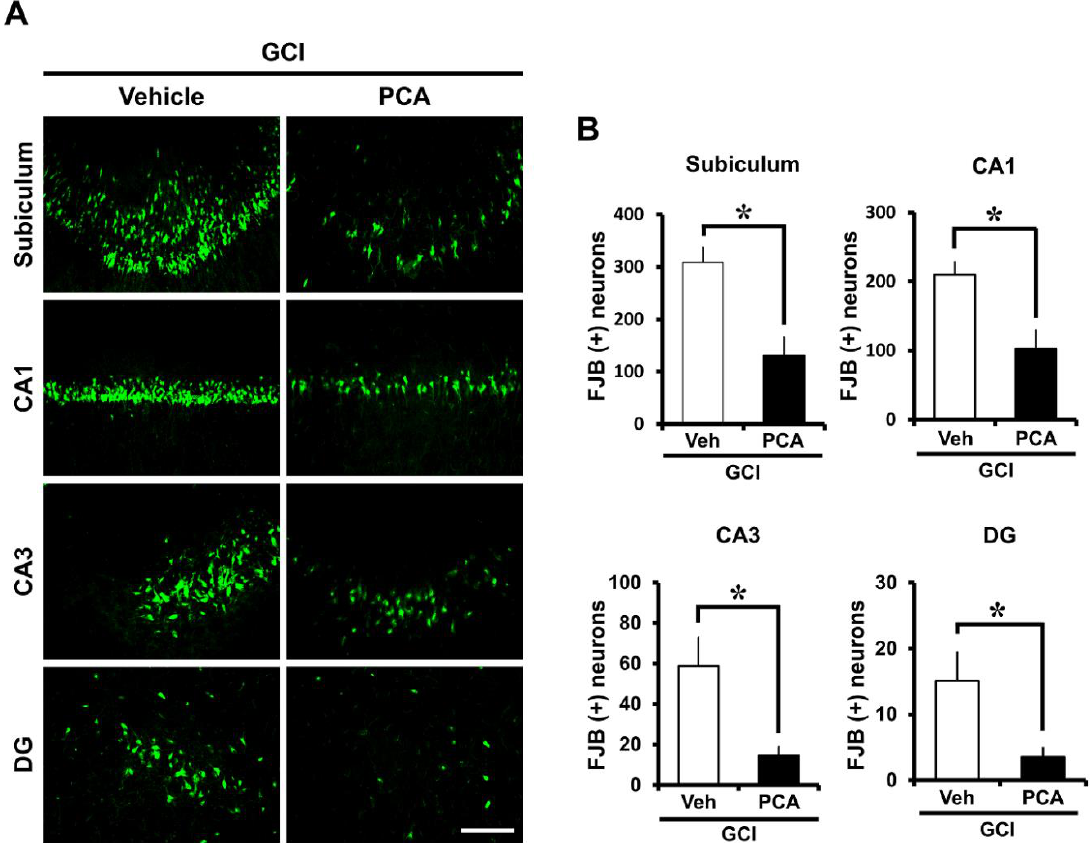
Figure 1. PCA treatment reduces ischemia-induced hippocampal neuronal death. Global ischemia induced neuronal death in the hippocampal areas: subiculum (Sub), CA1, CA3, and dentate gyrus (DG) one week after ischemic insult. Figure ( A ) shows FJB (+) neurons in the CA1, CA3, subiculum and DG. Oral post-treatment of PCA (30 mg/kg) for one week observed neuroprotective effect in the CA1, CA3, subiculum, and DG after ischemia ( n = 9). Scale bar = 100 µ m. ( B ) Bar graph indicating the quantification of degenerating neurons in the hippocampus. The number of FJB (+) neurons is reduced in PCA (30 mg/kg)-treated group in the subiculum, CA1, CA3, and DG compared to the vehicle-injected group. Data are mean ± S.E.M., n = 5 from each sham group. n = 9 from each ischemia group. * Significantly different from the vehicle-treated group, p < 0.05.